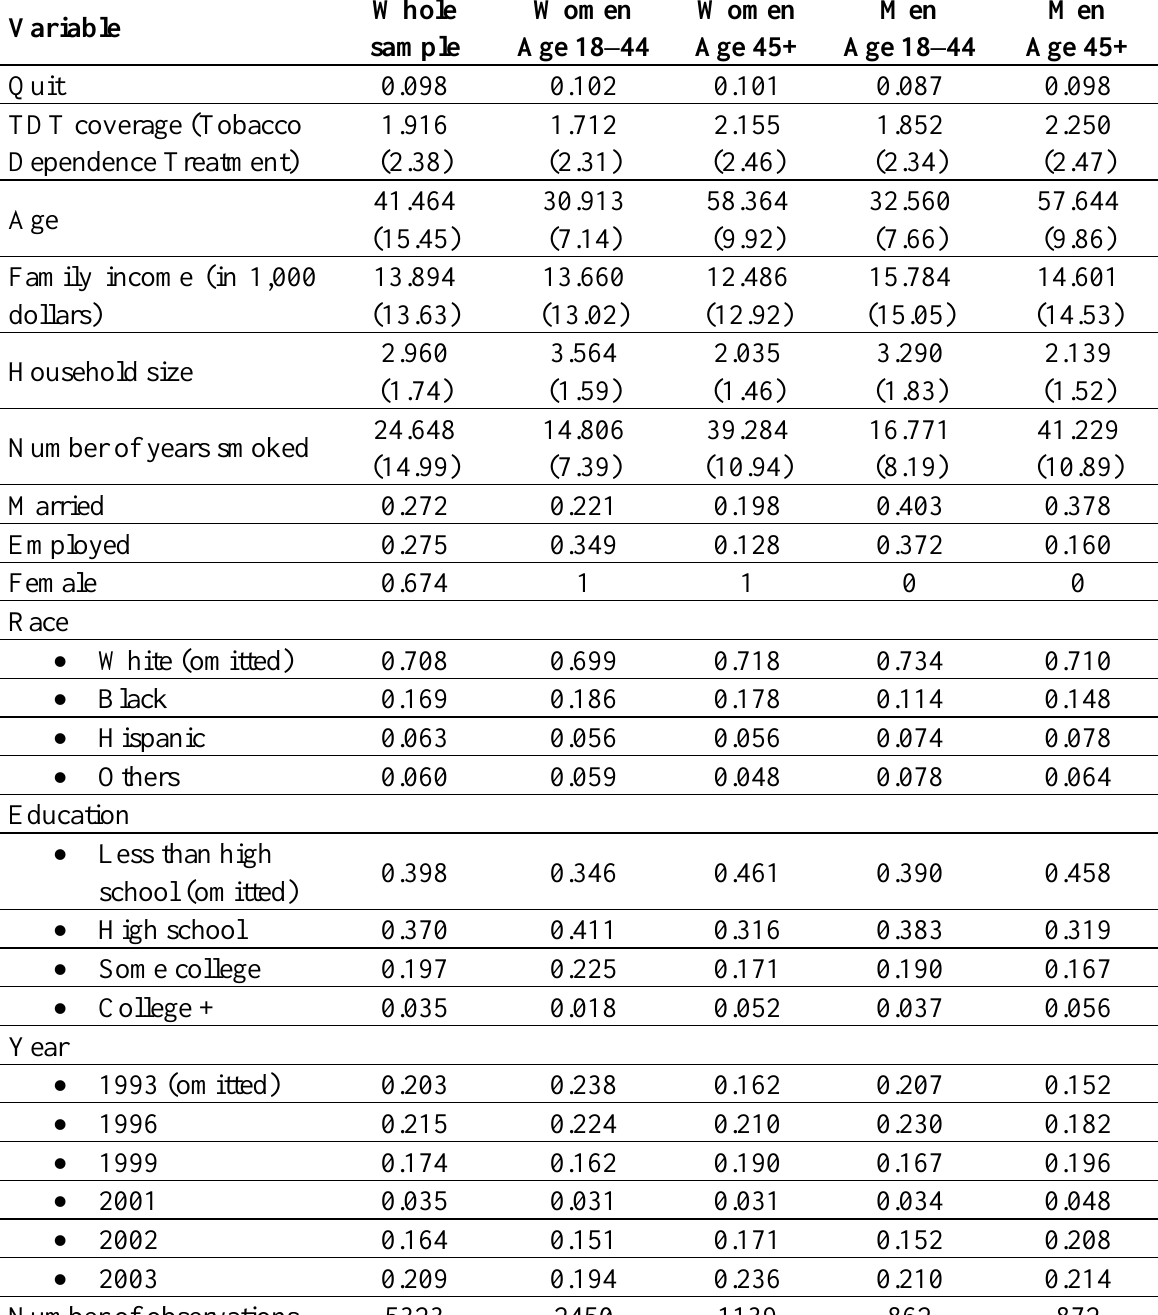
Table 1. Definitions and means of all